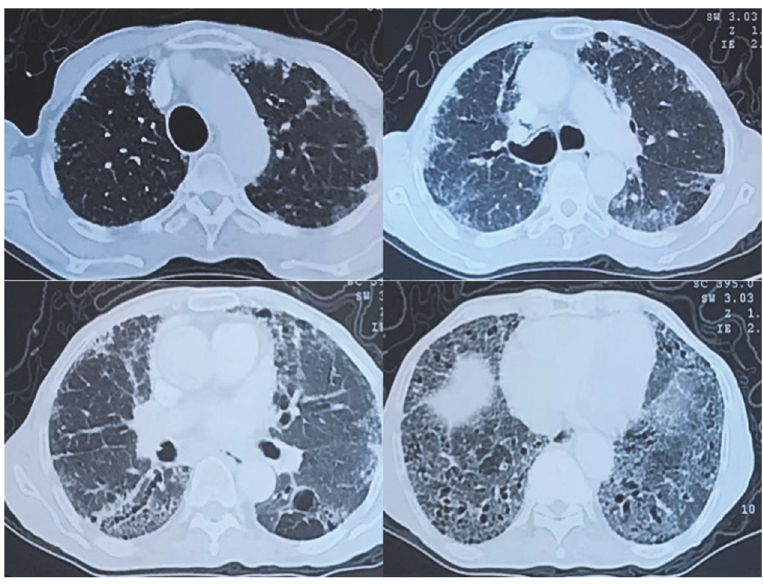
Figure 4: Control CT scan showing regression of the